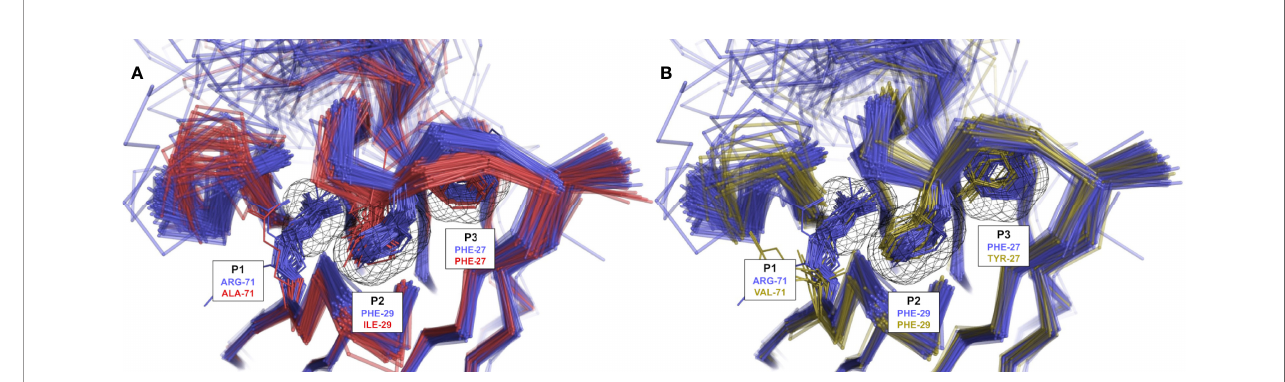
FIGURE 5 | Rendering of population shift upon residue changes at structurally determining positions. (A) The presence of a short aliphatic side-chain (such as Ile) at CDR-H1 position 29 (H1-13-1.2.1 in red) leads to a topology change in which CDR-H1 moves deeper into P2 and exerts steric pressure onto P1 in contrast to Phe- 29 (H1-13-1.1.1 in blue) observed in variants of IGHV3 mAbs. (B) The presence of Tyr at CDR-H1 position 27 (H1-13-1.1.3 in yellow) leads to similar steric pressure onto P1 in contrast to Phe-27 (H1-13-1.1.1 in blue) observed in variants of IGHV3 mAbs. The preference for non-Arg-71 frameworks is clearly visible in the presence of Ile-29 or Tyr-27. Some outliers were removed for